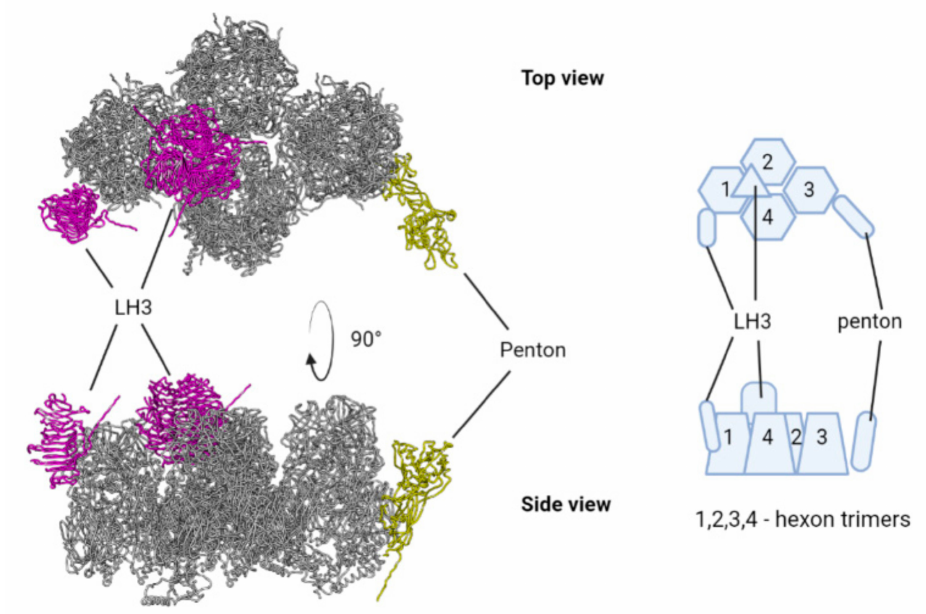
Figure 7. Icosaedral asymmetric unit (AU) of TAdV, penton base, and LH3 proteins are highlighted with